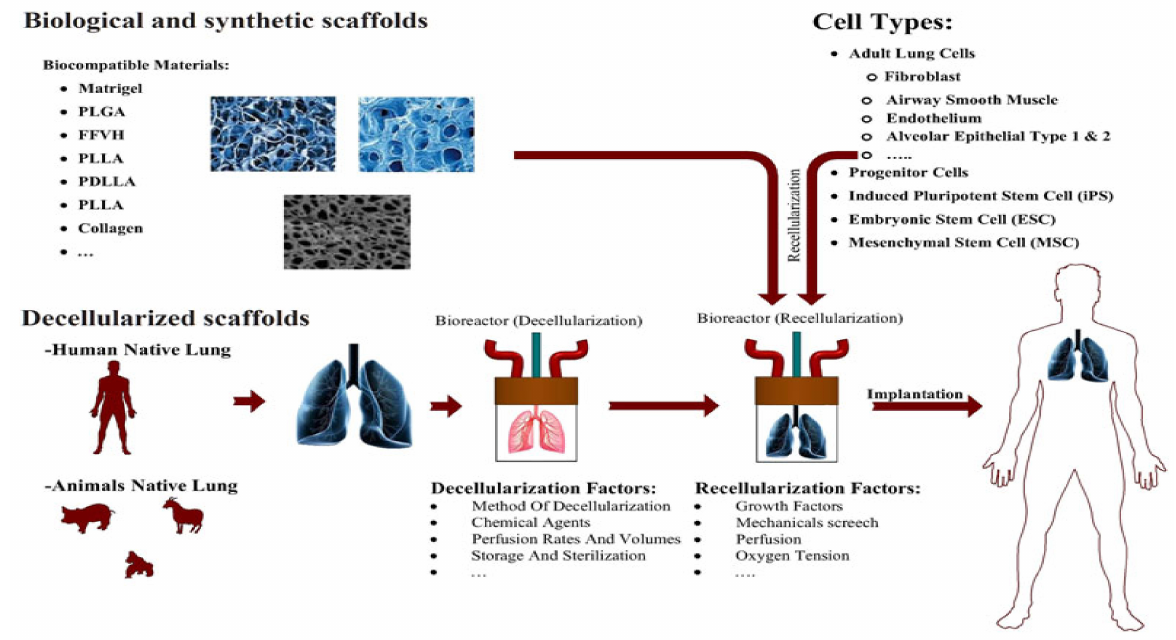
Figure 10. Design of effect of natural scaffolds for lung tissue via the best method of decellularization with different biocompatible materials. Different natural and synthetic scaffolds have been applied for lung tissue engineering with different kinds of cells. Reused permission with from [100] Copyright © 2021 Journal of Cellular